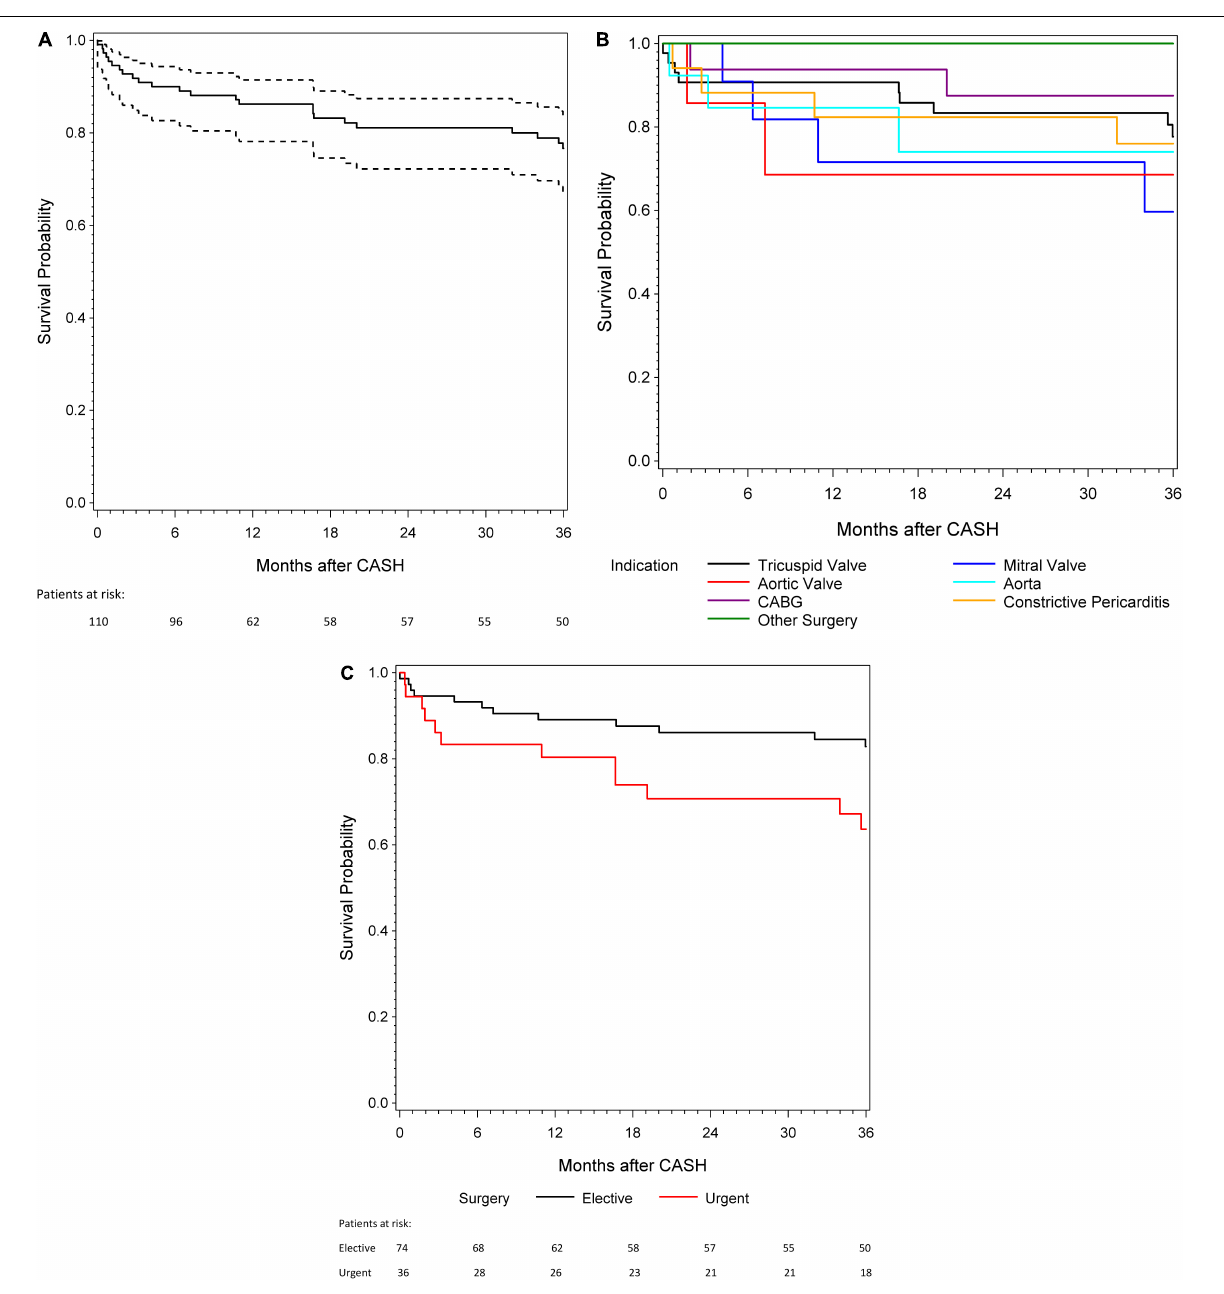
FIGURE 1 | (A) A 3-year survival for patients with cardiac surgery after heart transplantation (CASH). (B) A 3-year survival according to the different indications for CASH. (C) A 3-year survival in patients with urgent and elective indication for